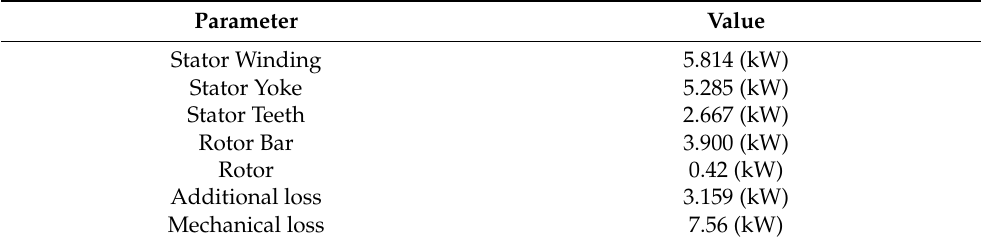
Table 2. Loss distribution of induction motor.